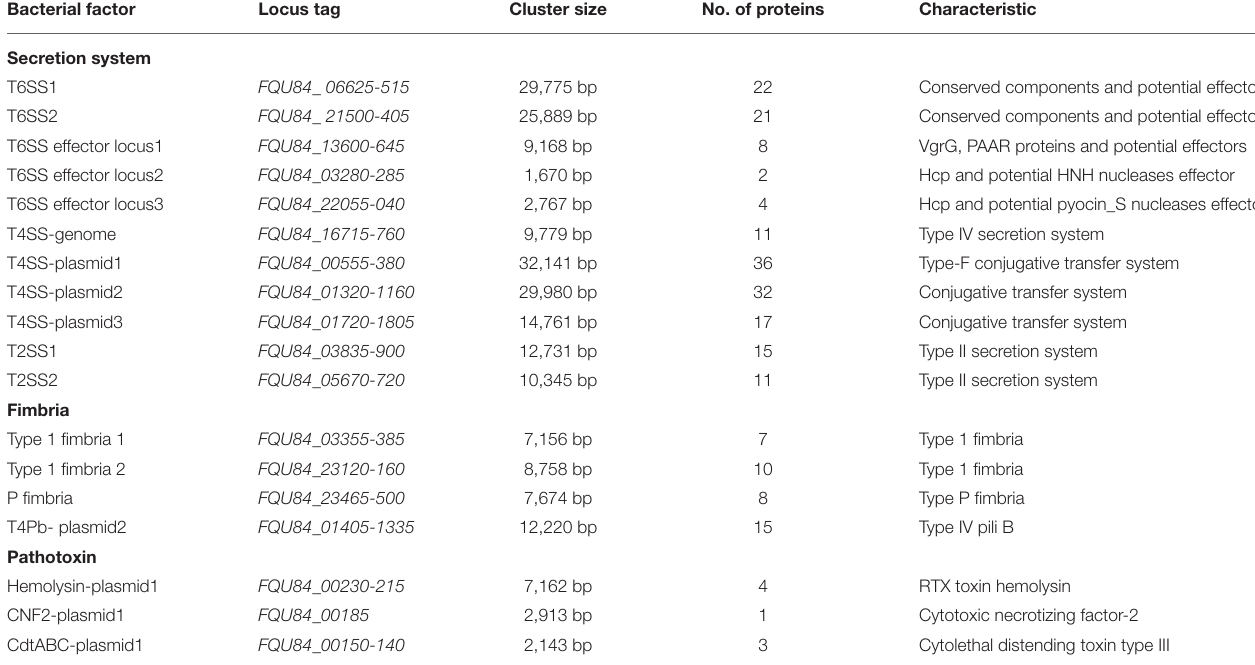
TABLE 1 | Putative secretion systems, fimbriae, and pathotoxins from O2:K1 E. coli strain BCE049. Bacterial factor Locus tag Cluster size No. of